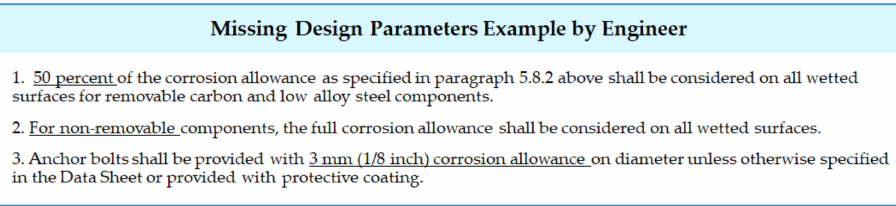
Figure 19. Example of design parameter sentences missing by the subject of